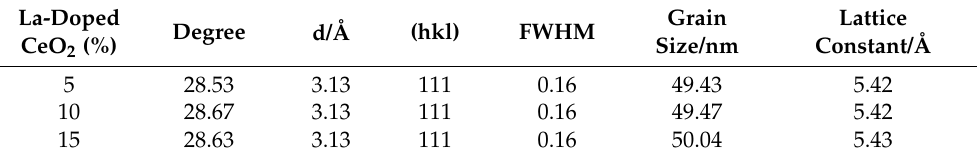
Figure 1. ( a ) XRD patterns of cerium oxide doped with lanthanum at different concentrations. ( b ) Magnified peaks at 28.6° of 2 θ . Table 1. XRD parameters of cerium oxide doped with lanthanum at different concentrations.